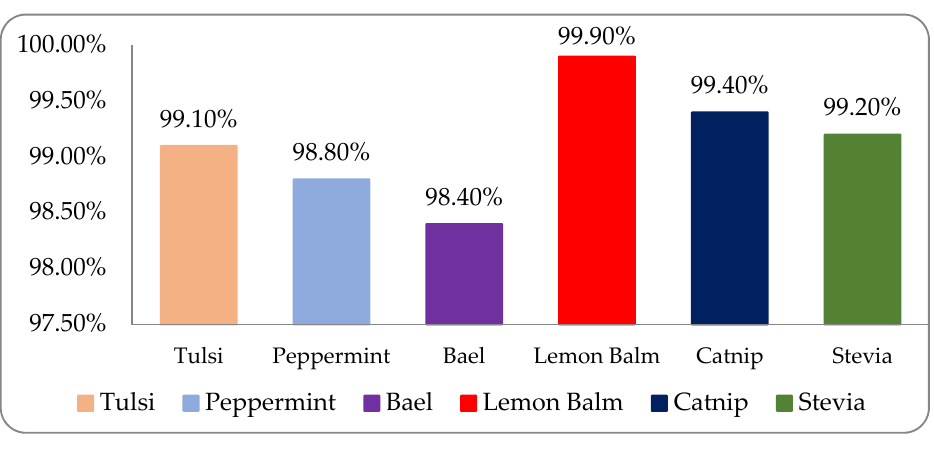
Figure 10. MLP based classification of six medicinal plant leaf varieties on ROO’s size (250 × 250).